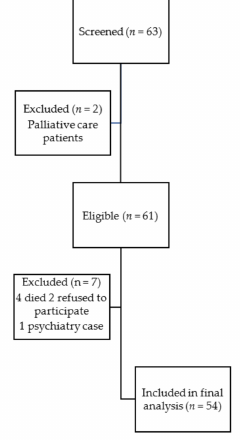
Figure 1. Flowchart of patient